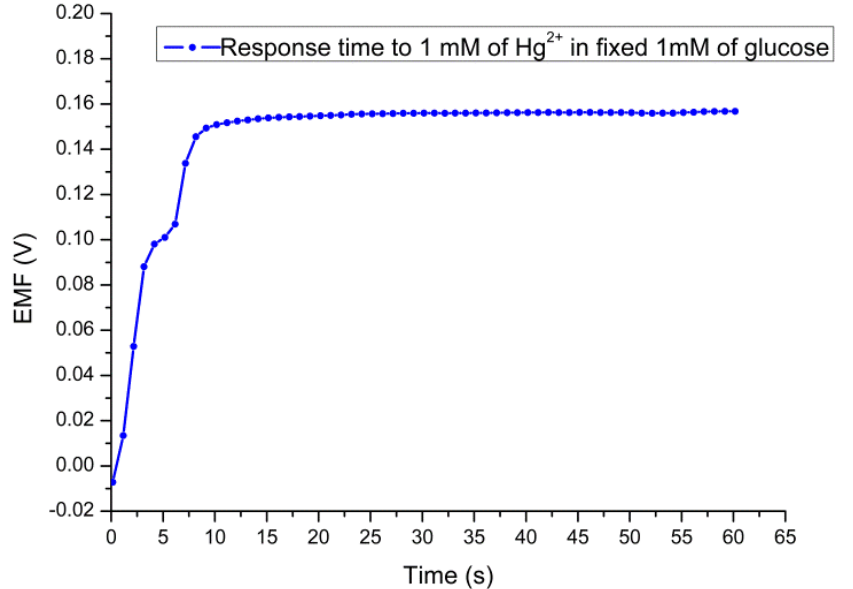
Figure 8. The response time of the proposed